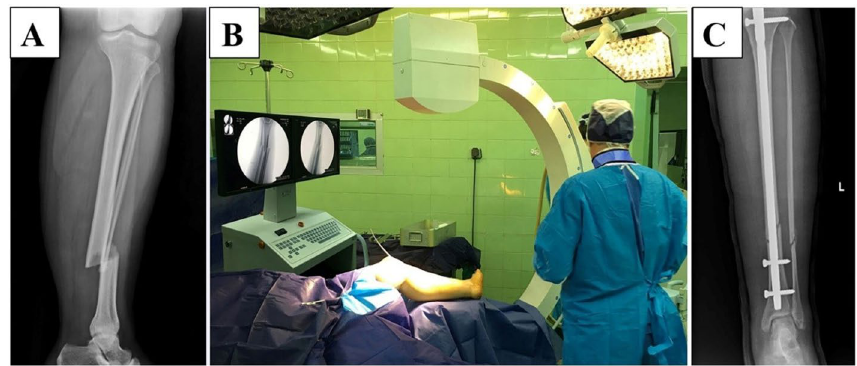
Figure 7 . Interlocking of the intramedullary nail using FH technique, ( A ) The X-ray image of the patient’s left foot before the surgery, ( B ) Inserted guide-wire inside the tibia bone under fluoroscopy control, ( C ) The X-ray image of the patient’s left foot one day after the